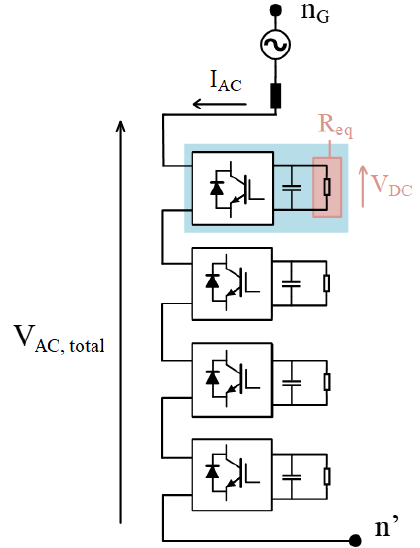
Figure 4. Simplified model to analyze the input port connection.